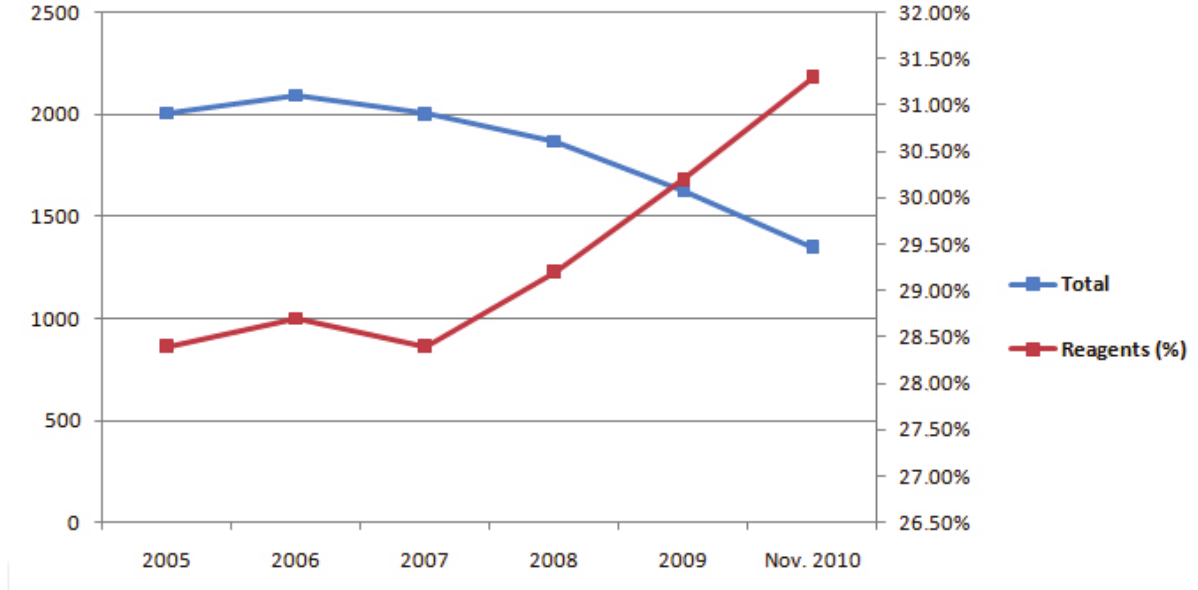
Figure 1. Comparison between absolute sample numbers and percentage of samples reactive to